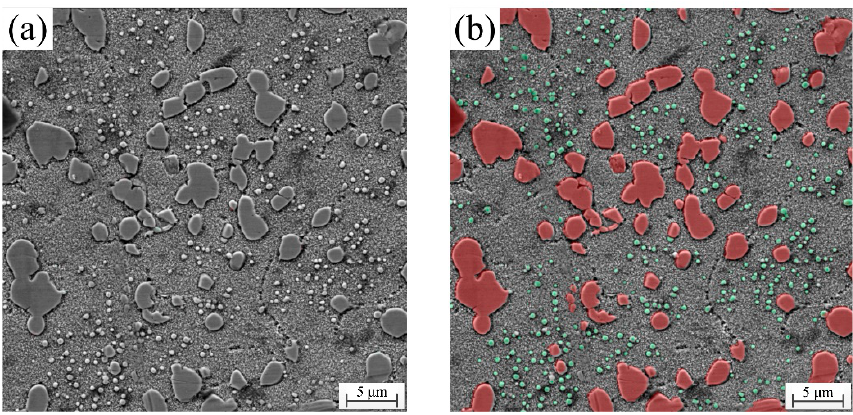
Figure 2. The original image ( a ) and segmented image ( b ) by the U-Net.